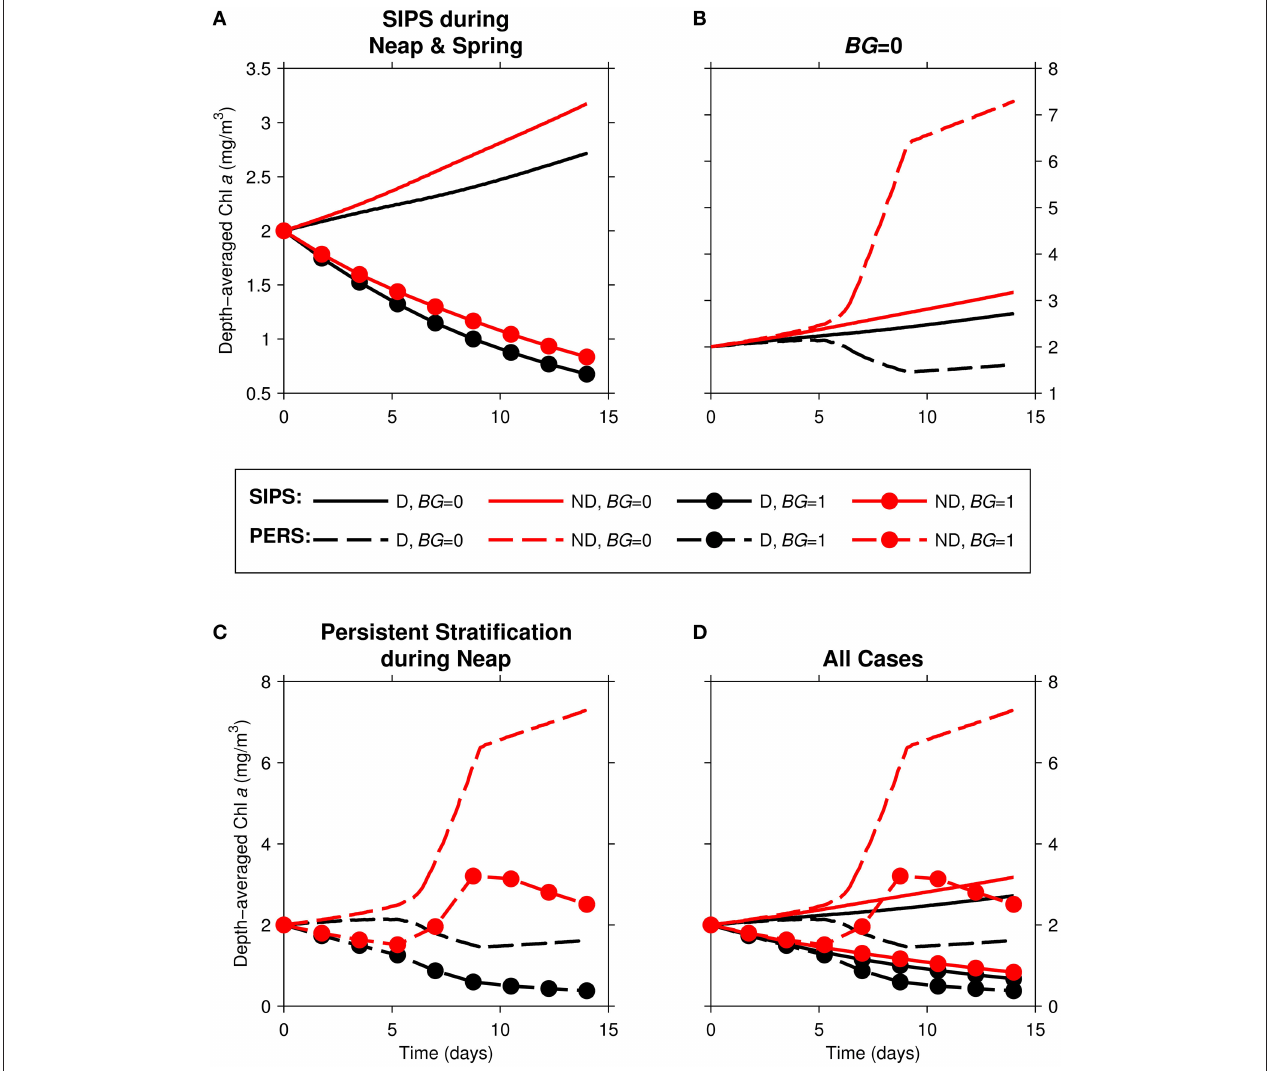
FIGURE 5 | Time series of computed depth-averaged phytoplankton biomass for generic channel. Results from eight 14-day simulations are shown. Diatoms (“D,” black) were assigned a sinking speed of 3m/d; non-diatoms (“ND,” red) had a sinking speed of 0m/d. “SIPS” (solid lines) represents strain-induced periodic stratification. “PERS” (dashed lines) represents persistent neap-tide stratification. (A) SIPS (with and without benthic grazing), (B) SIPS and PERS with BG = 0 , (C) PERS (with and without benthic grazing), (D) all 8 cases. Benthic grazing rate BG is in units m 3 /m 2 /d (marker if non-zero BG , no marker if zero BG